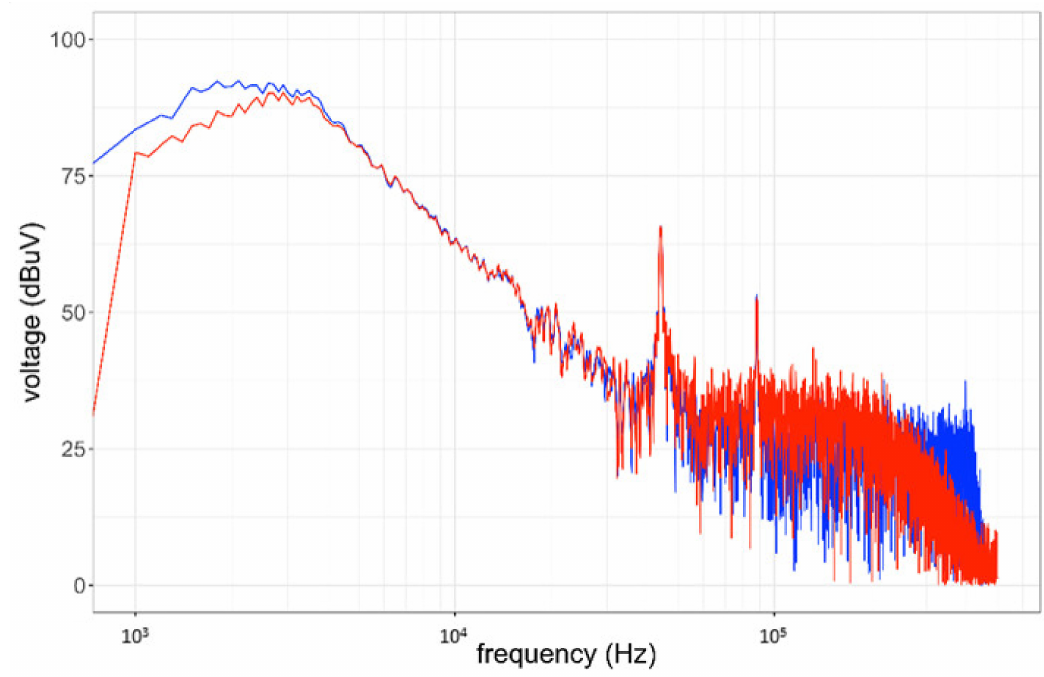
Figure 14. Comparison of the FFT spectra obtained from IMFs 2–7 extracted with EEMD ( red ) and from the original signal ( blue ).